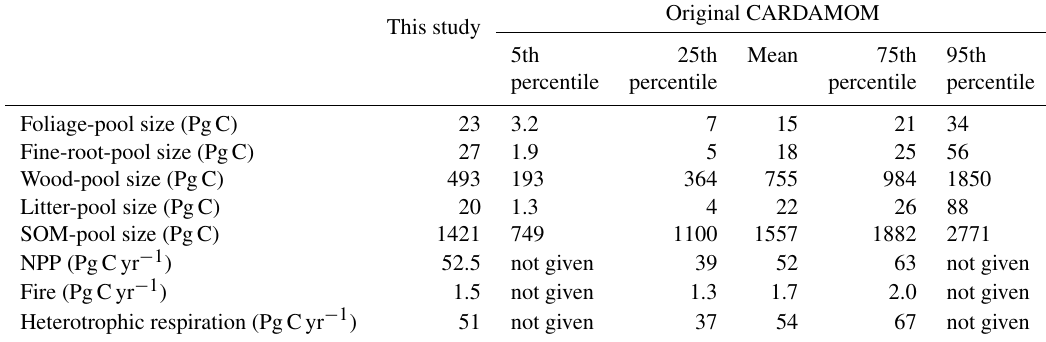
Table 2. Global annual mean C-pool sizes, NPP and heterotrophic-respiration fluxes in the C-cycle model assuming steady states under the climate conditions of 2001–2010, compared to the means and percentile ranges from the original CARDAMOM results during